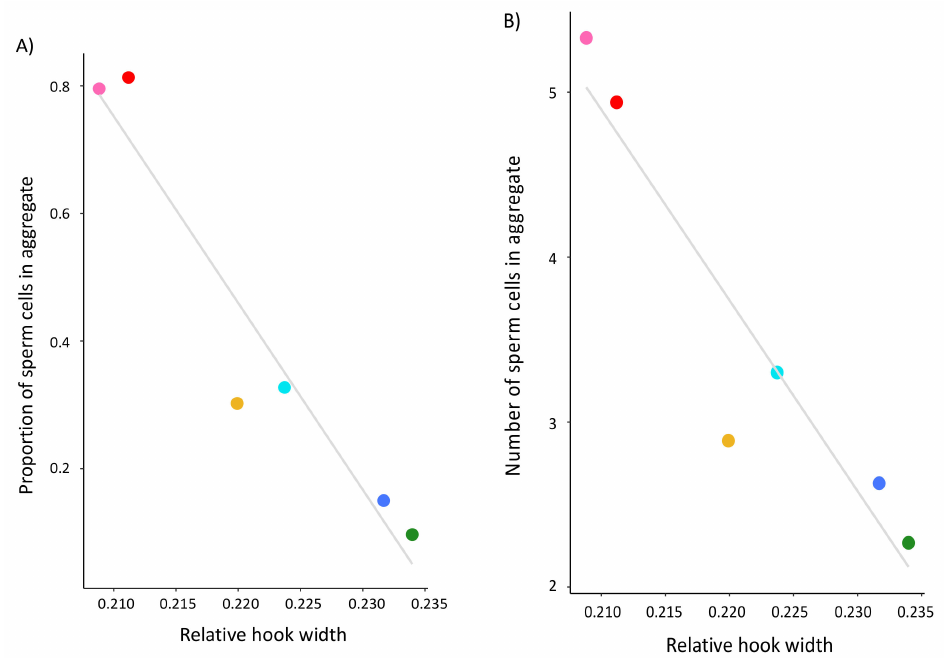
Figure 3. Mean width of the apical sperm hook negatively associates with the frequency ( A ) and size ( B ) of sperm aggregates produced within six species of Peromyscus mice. Statistical analyses were conducted using a PGLS to control for phylogenetic relationships with the regressions, which are indicated by a line in gray. In both panels, species are indicated by the same color patterns from Figure 2. Note truncated